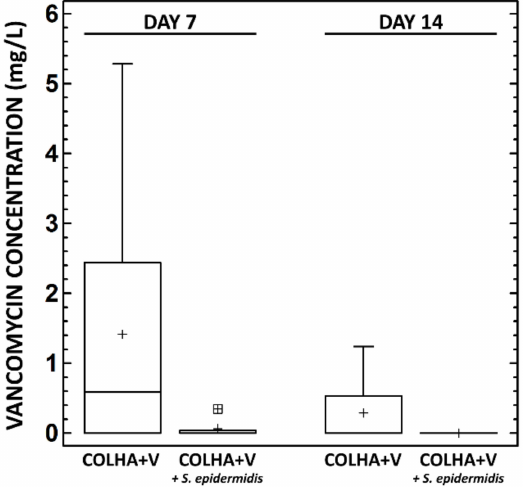
Figure 7. Concentration of vancomycin in the rat blood plasma 7 and 14 days following implantation. Blood samples were taken from the animals with COLHA+V implants with and without S. epidermidis . No statistically significant differences were determined between the medians at the 95% confidence level (0.05, Kruskal–Wallis